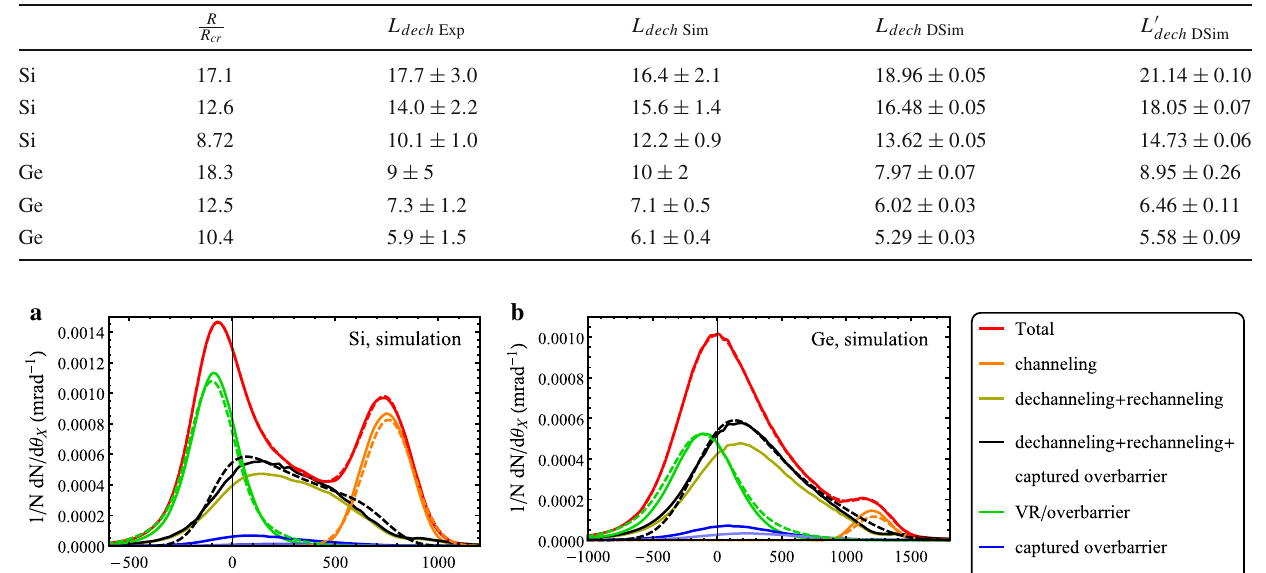
Table 3 Experimental ( L dech Exp ) and simulated (both from distribu- tion ( L dech Sim ) and directly from the dependence of channeling effi- ciency on the penetration depth ( L dech DSim ) as well as from the same